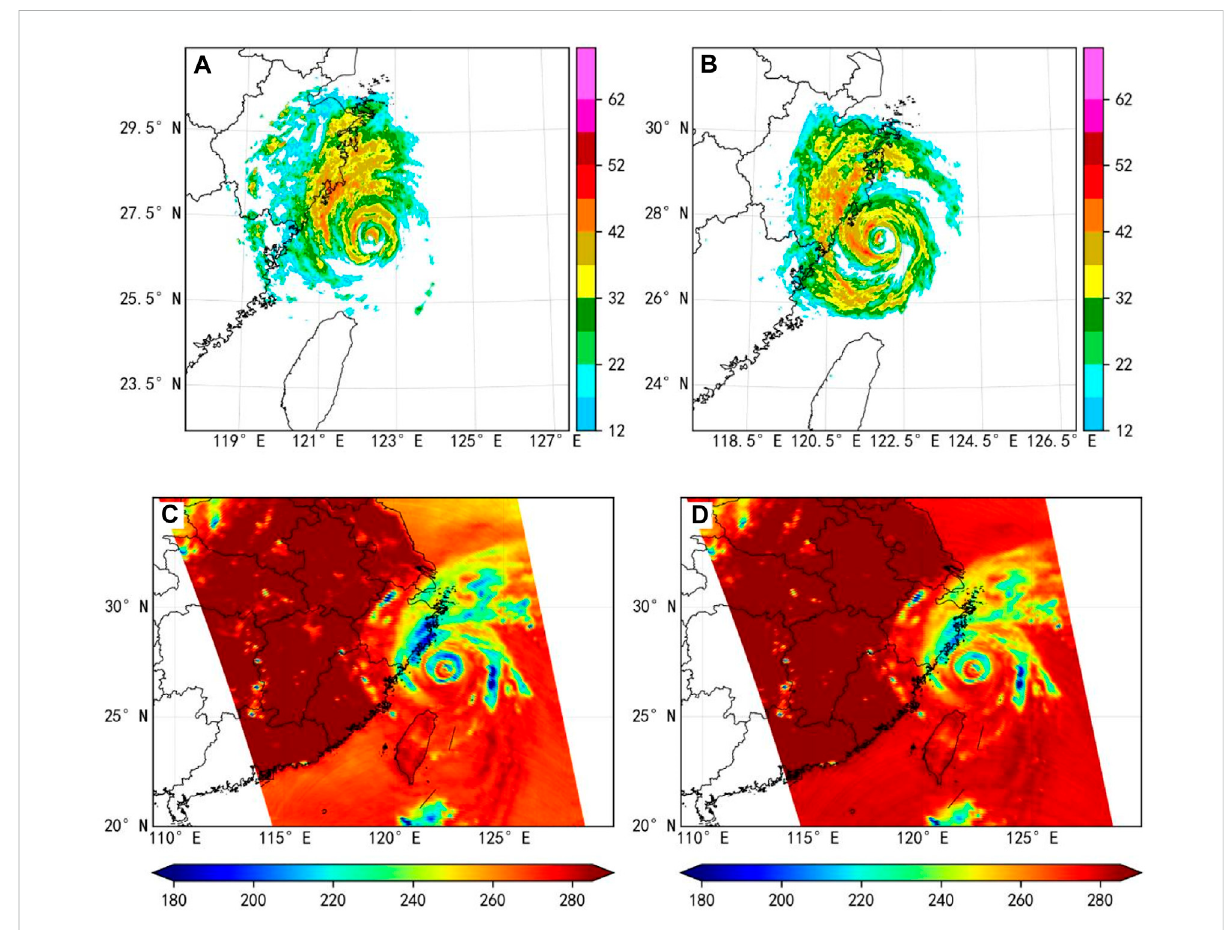
FIGURE 3 Horizontal distribution of re fl ectivity (unit: dBz) at 0.5 ° elevation at (A) 06:00, (B) 12:00 UTC on 9 August 2019. FY-3B polar orbit satellite MWRI 89 GHz channel (C) vertical and (D) horizontal polarization detection brightness temperature (unit: K) at 15:00 on 9